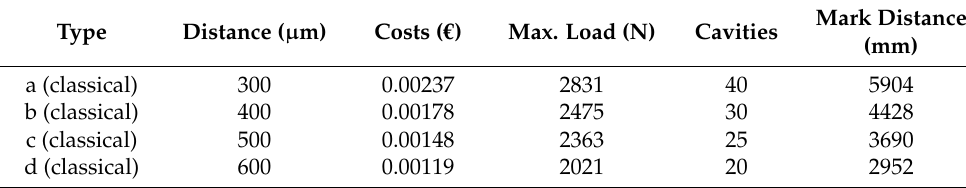
Table 2. Benchmark values for the classical design with linear and parallel